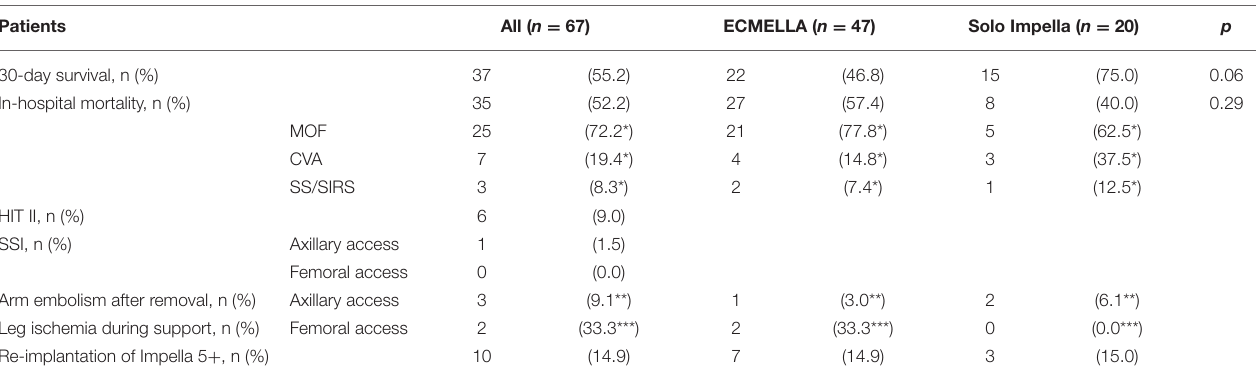
TABLE 2 | Clinical outcomes of Impella 5 + support focusing on adverse